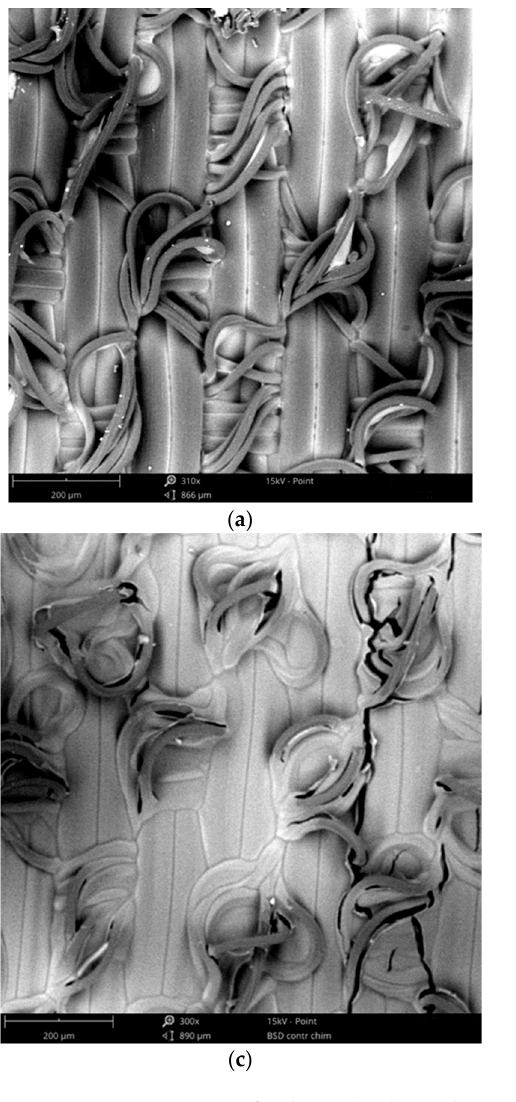
Table 3. CIELAB values for polyamide fabric and electrodes coated by the two PEDOT:PSS solutions.